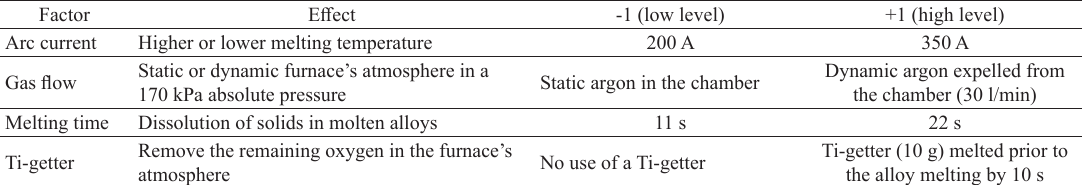
Table 2: Factors, levels and effects of the Zr and melting time. Factor